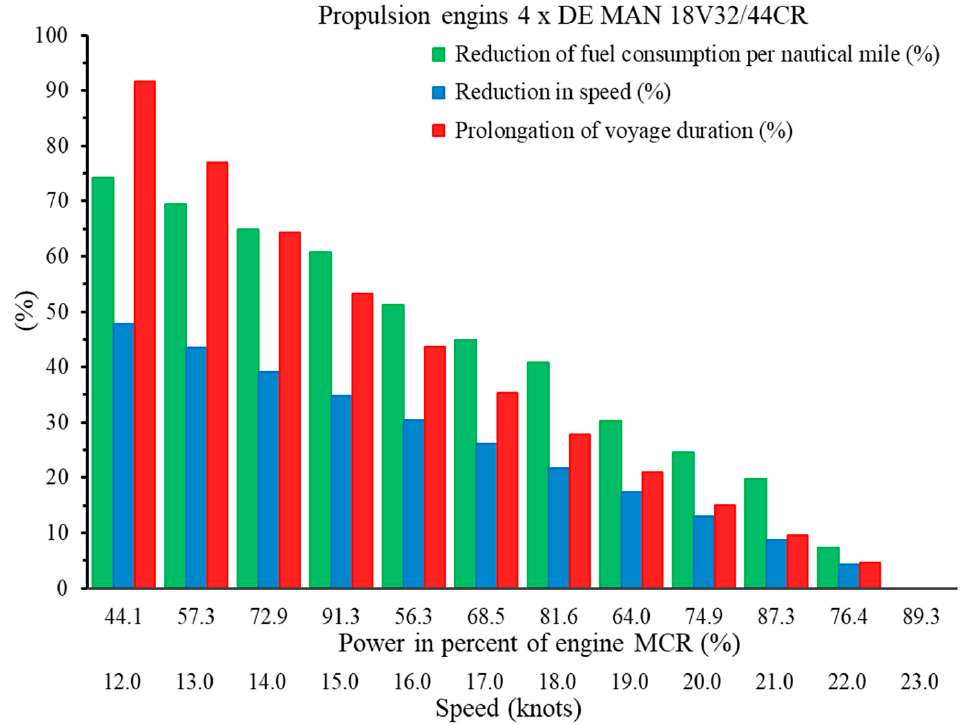
Figure 15. Propulsion with four medium-speed diesel engines—Con fi guration 4.